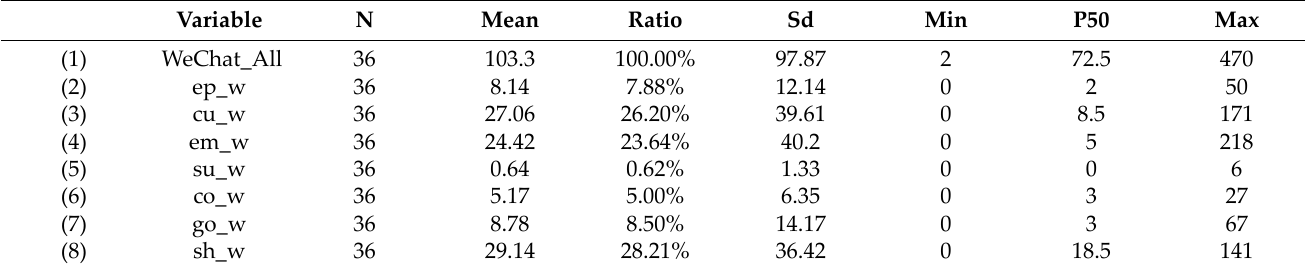
Table 2. Results of total and level‑1 dimension analysis on social